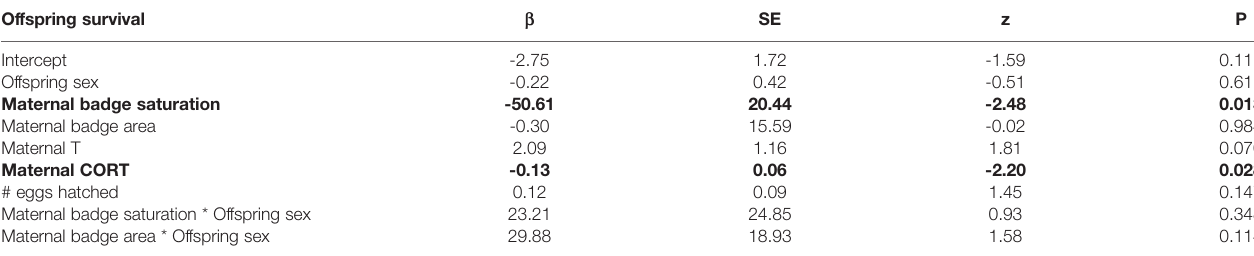
Maternal badge traits and hormone concentrations were measured during pregnancy. Maternal identity and site of origin included as random effects. Predictor variables in bold are statistically signi fi